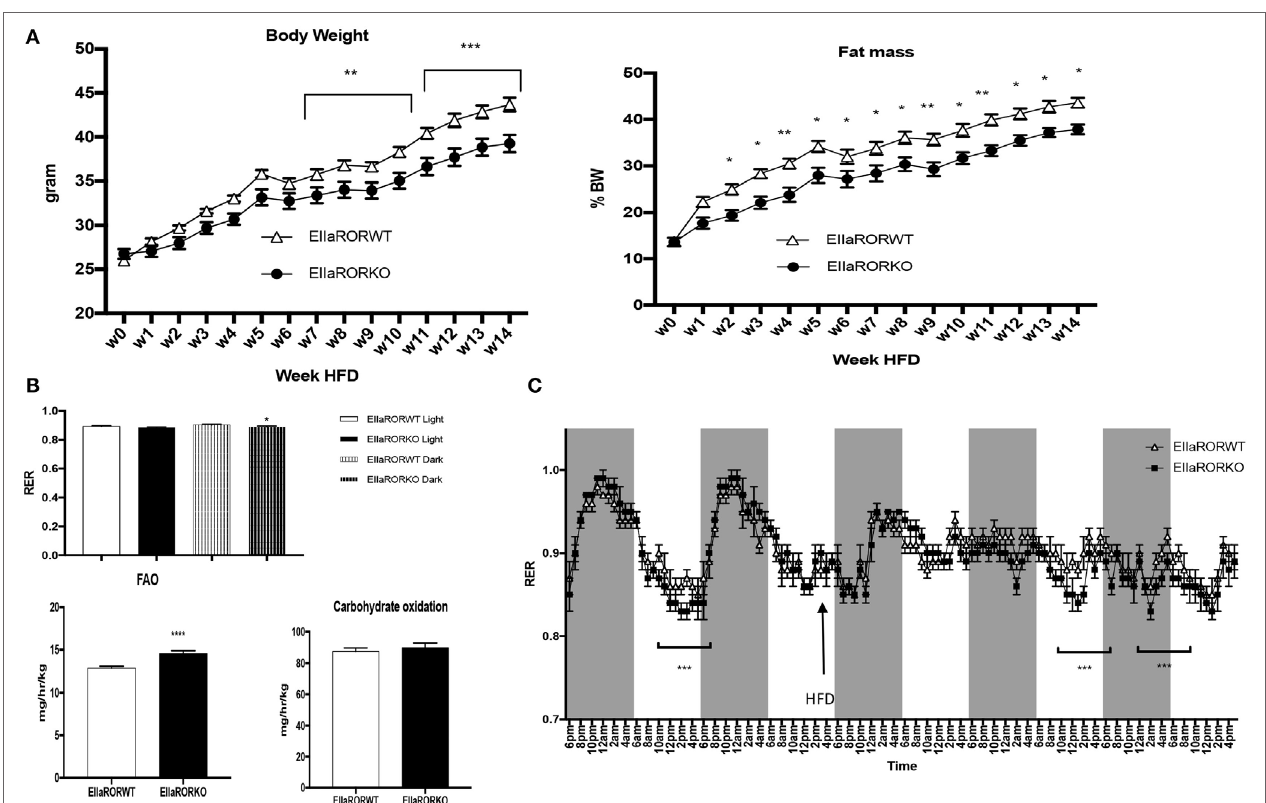
FigUre 3 | EIIAROR α KO mice are resistant to diet-induced obesity. (a) Weekly body weight and adiposity of 3-month-old males EIIAROR α WT (white triangle, n = 7) and EIIAROR α KO (black square, n = 8) mice fed with high fat diet (HFD). (B) Fatty acid oxidation (left) and carbohydrates consumption (right) of the same males EIIAROR α WT (white bar, n = 7) and EIIAROR α KO (black bar, n = 8) fed with HFD calculated over a 5-day period (* p < 0.05, ** p < 0.01, *** p < 0.001). (c) Indirect calorimetry measurement of the same animals EIIAROR α WT (white triangle, n = 7) and EIIAROR α KO (black square, n = 8) under chow diet and then challenged (black arrow) with HFD (right panel). Average of respiratory exchange ratio (RER) value for day and nighttime of the same EIIAROR α WT (white, n = 7) and EIIAROR α KO (black, n = 8) littermates during day (solid pattern) or night (shaded pattern) over a 5-day period under